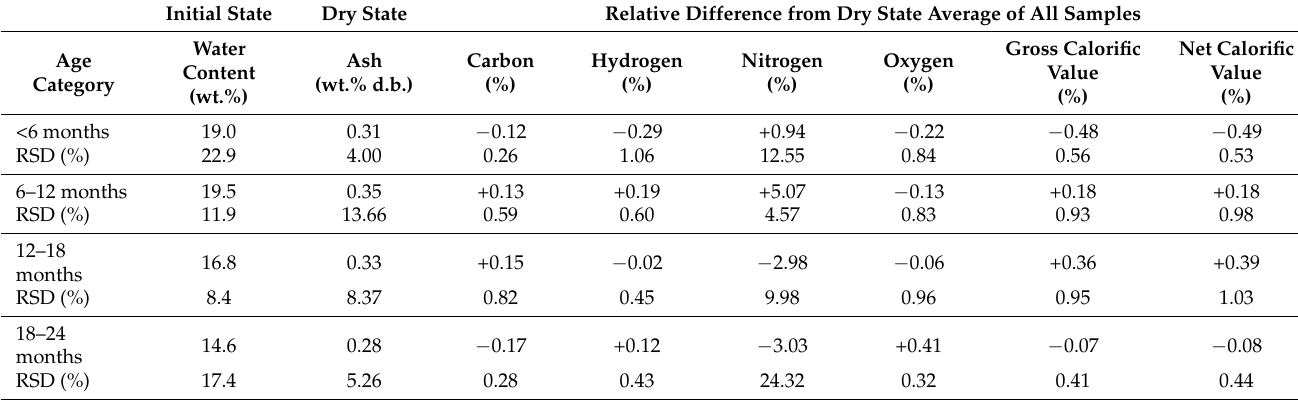
Table 2. Variability of spruce wood parameters between age